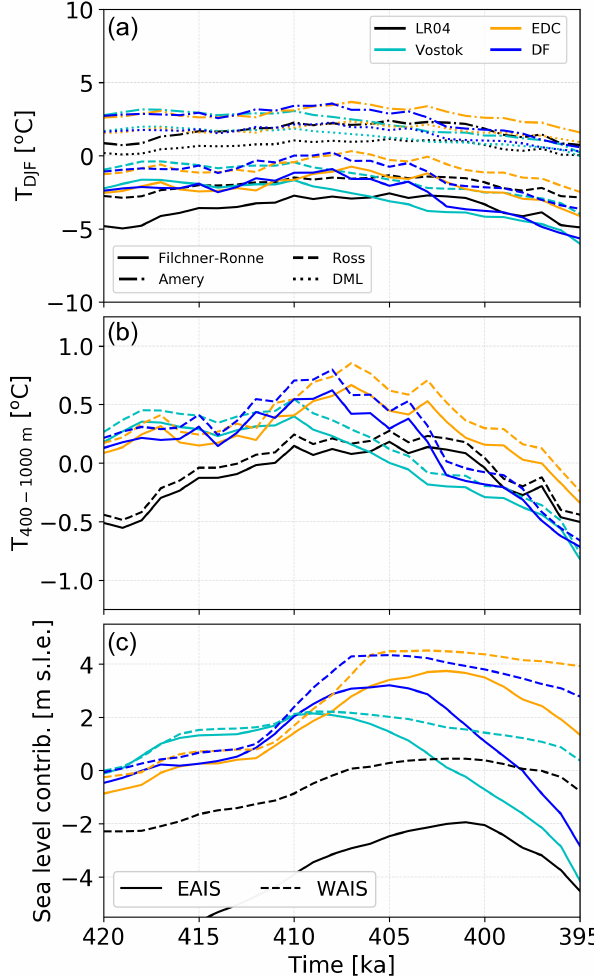
Figure 9. Evolution throughout MIS11c for each CFEN member for (a) summer surface air temperature [ ◦ C] averaged over the main Antarctic ice shelves, (b) ocean temperatures averaged between 400 and 1000m [ ◦ C] for the Filchner–Ronne and Ross ice shelves, and (c) sea level contribution by EAIS and WAIS. Colours denote the respective CFEN member, while line styles in panels (a) and (b) denote each ice shelf and each ice sheet in panel (c) . DML refers to all smaller ice shelves along the Dronning Maud Land